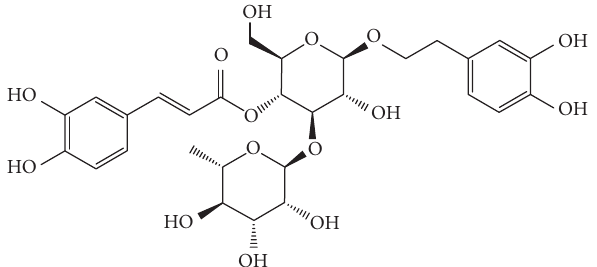
Figure 1: Chemical structure of acteoside